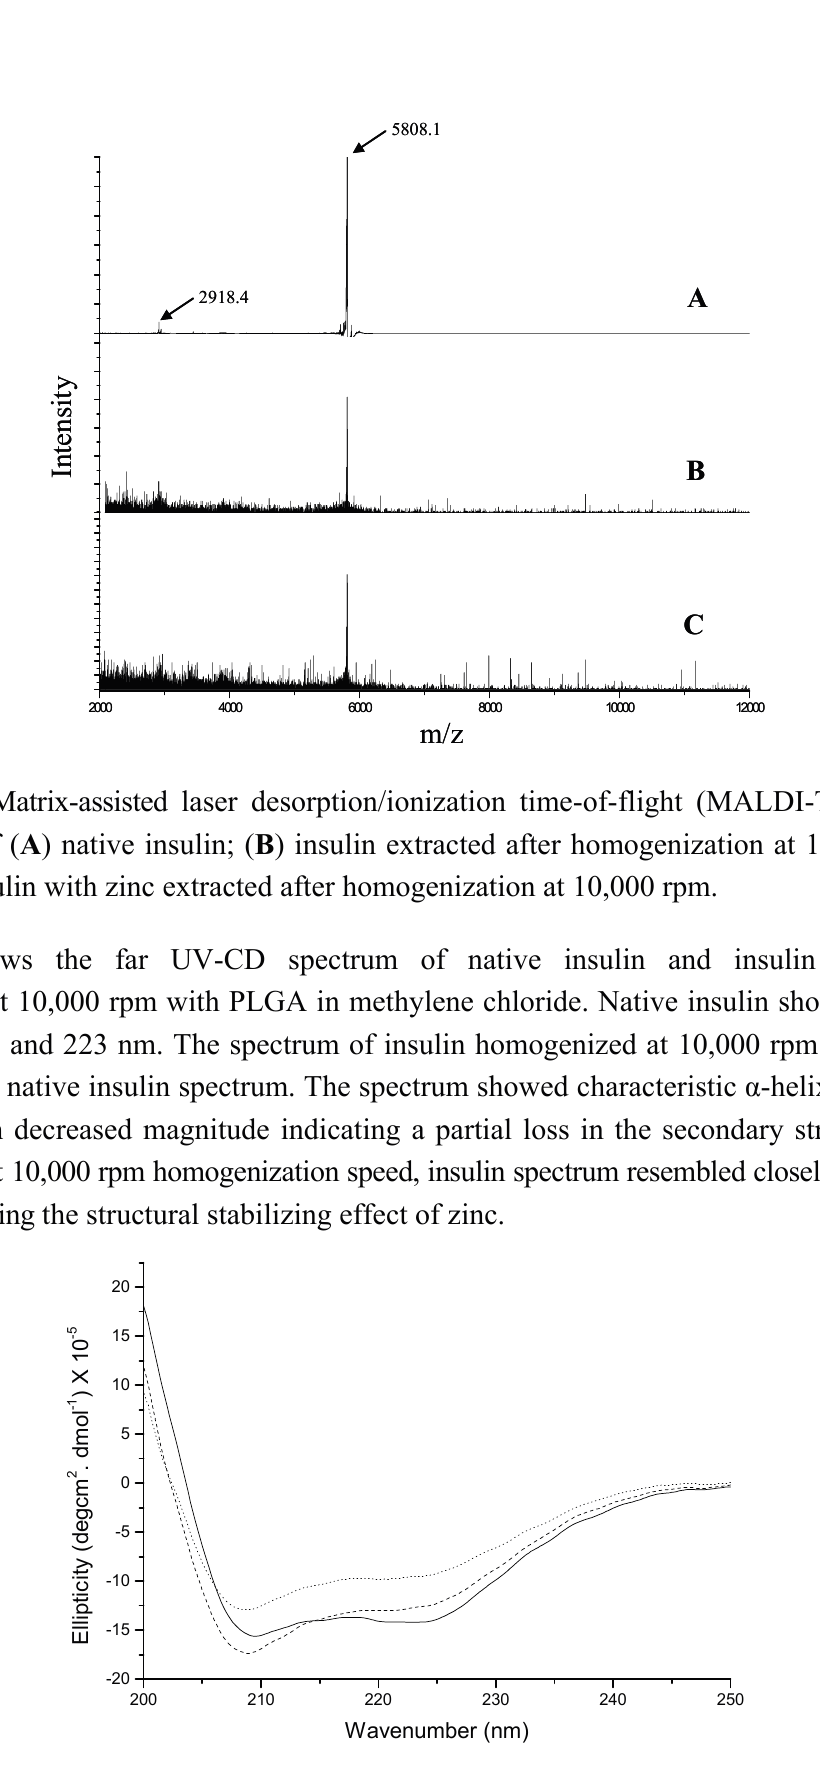
Figure 7. Far UV-circular dichroism (CD) of insulin extracted in the aqueous phase. Solid line: native insulin, dotted line: insulin extracted after homogenization at 10,000 rpm, and dashed line: insulin with zinc extracted after homogenization at 10,000